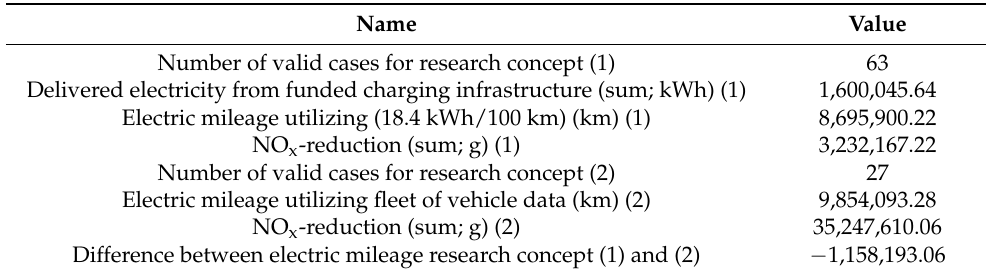
Table 4. Key figures for research concepts (1) and